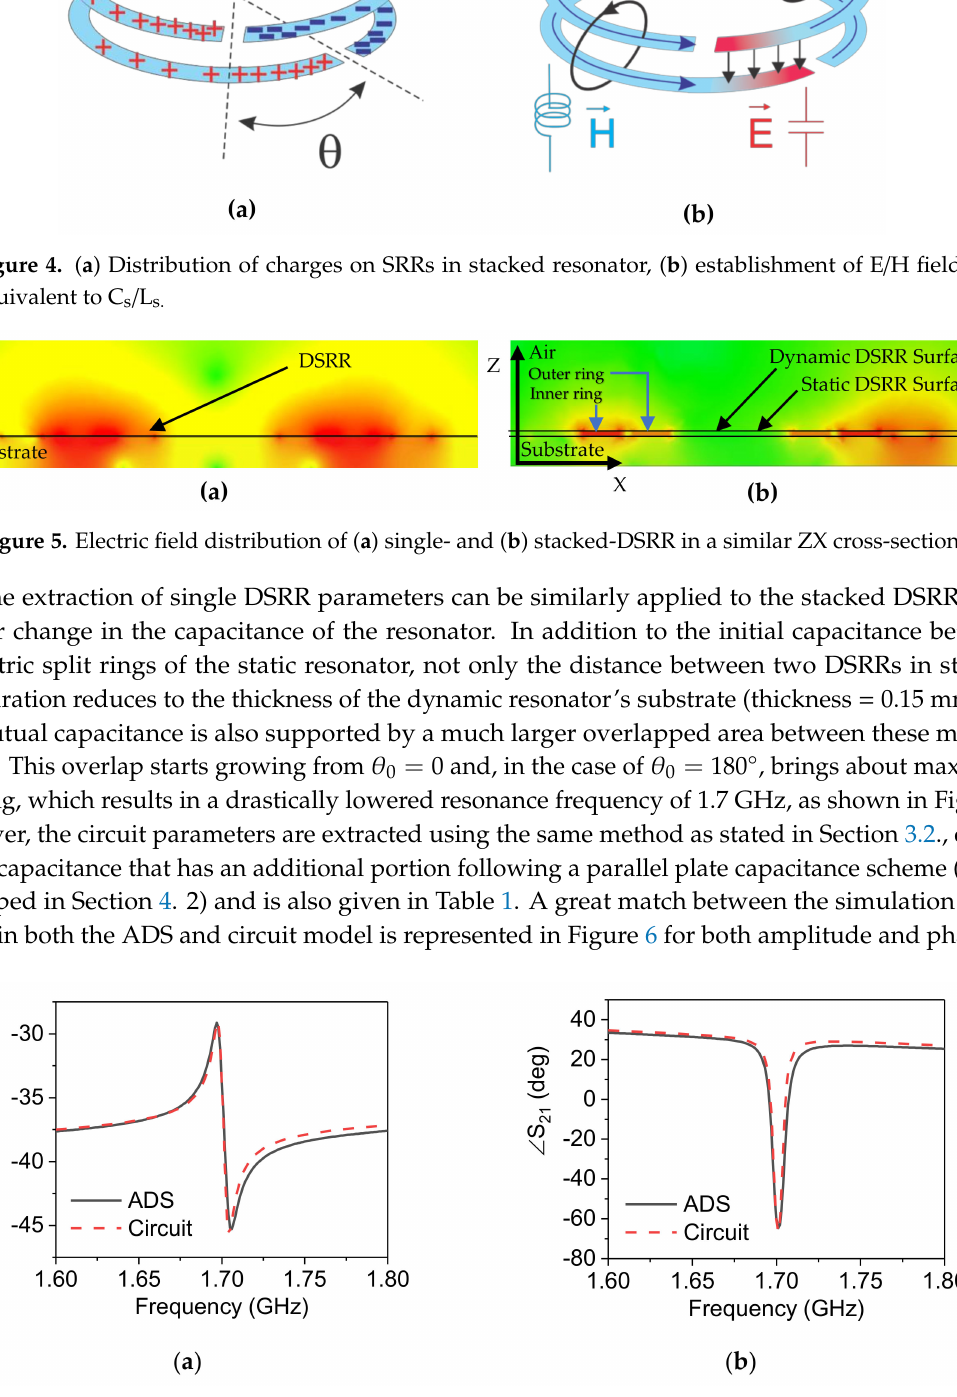
Figure 6. Comparison between ADS simulation and equivalent Circuit model for ( a ) | S 21 | and ( b ) ∠ S 21 of stacked